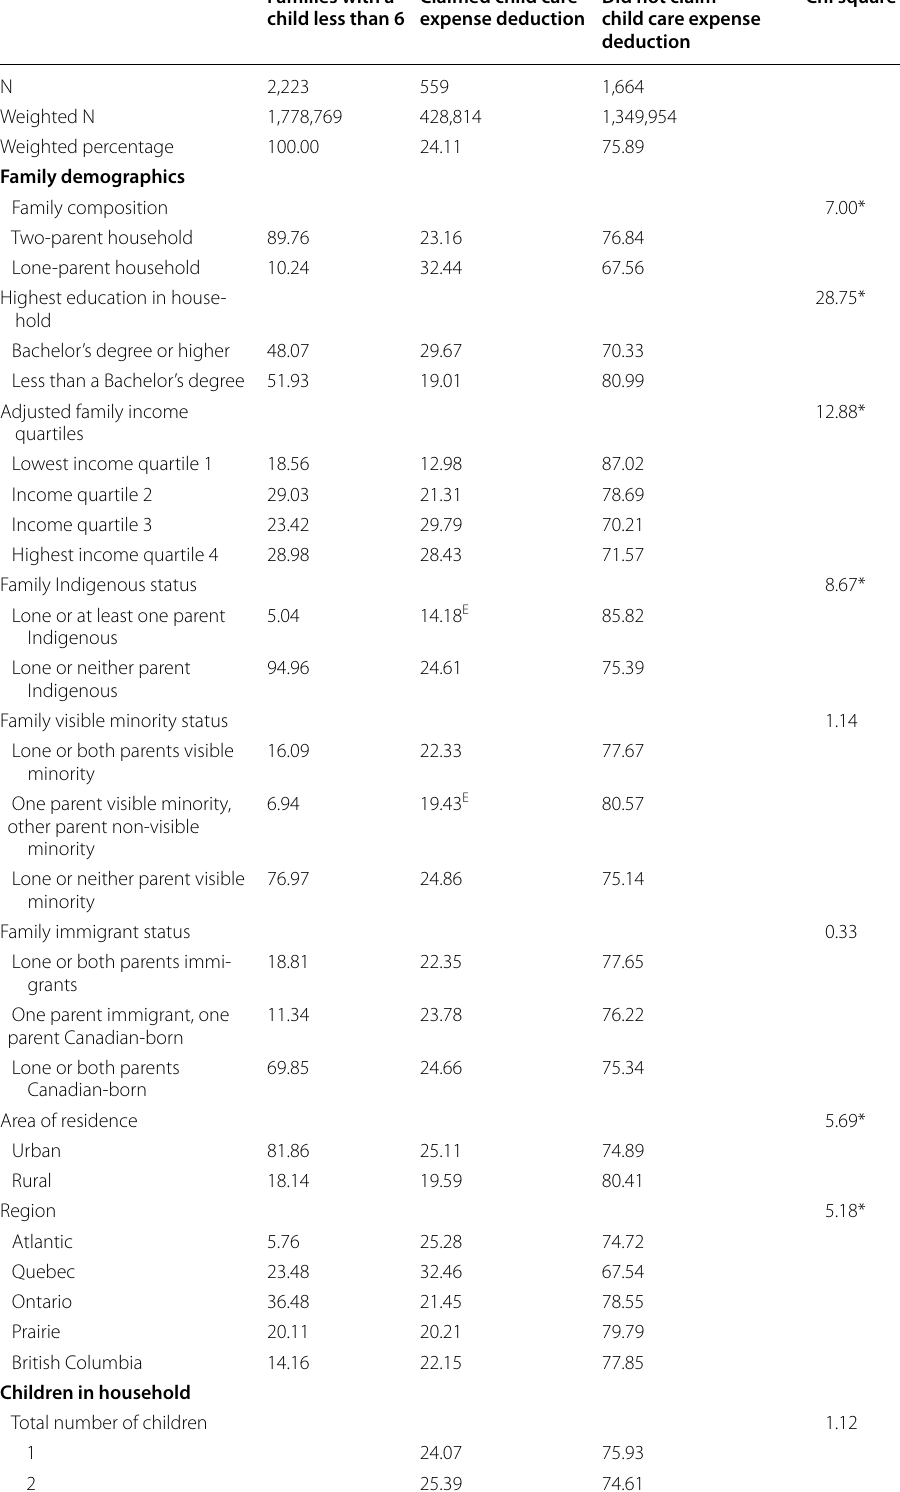
Table 3 Characteristics of families with at least one child less than 6 years old who did and did not claim the child care expense